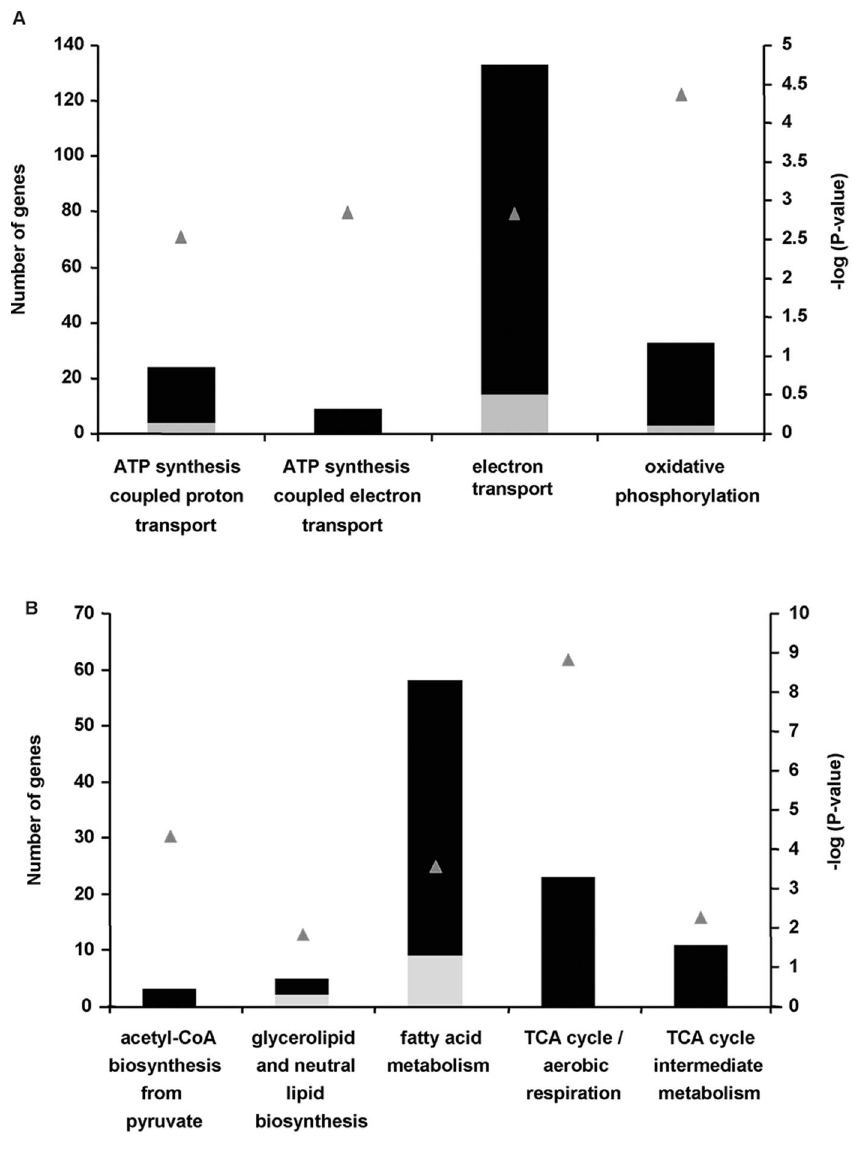
Figure 2. 2-AA treatment differentially modulates the genes involved in energy production and intermediate metabolism in skeletal muscle. Differentially expressed genes involved in energy production (A) and intermediate metabolism (B) in response to 2-AA treatment. Grey boxes represent up–egulation, and black boxes represent down-regulation, of the respective gene in muscle from 2-AA treated versus control mice. The negative log10 of p-values represented by gray triangles are shown in the right vertical axis. The expression of certain key genes is down- regulated, consistent with the in vivo 31 P-NMR data (Figure 1 and Table 2).